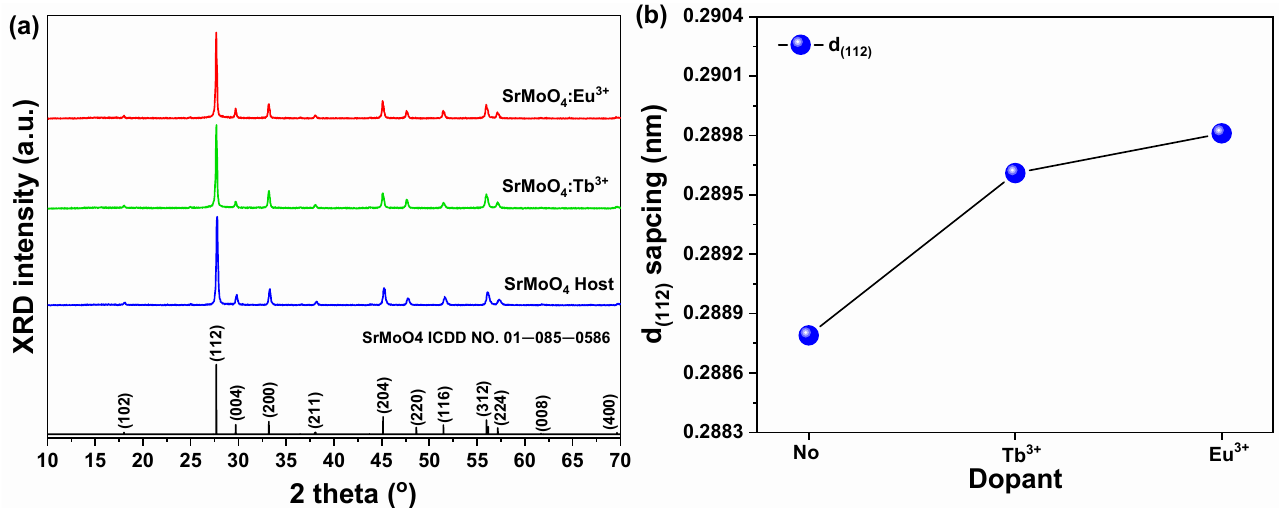
Figure 2. ( a ) XRD patterns of SrMoO 4 and SrMoO 4 :RE 3+ , ( b ) change of d (112) spacing according to rare-earth ions.